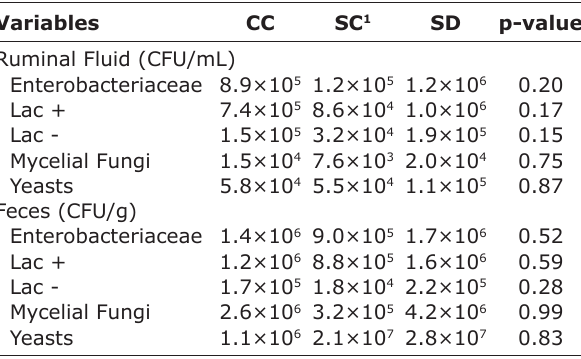
of comparison of means by the Kruskal–Wallis test with 5% significance. 1 Supplementation with fungi: Aspergillus terreus (isolated VN15) and Trichoderma longibrachiatum (isolated VN20)